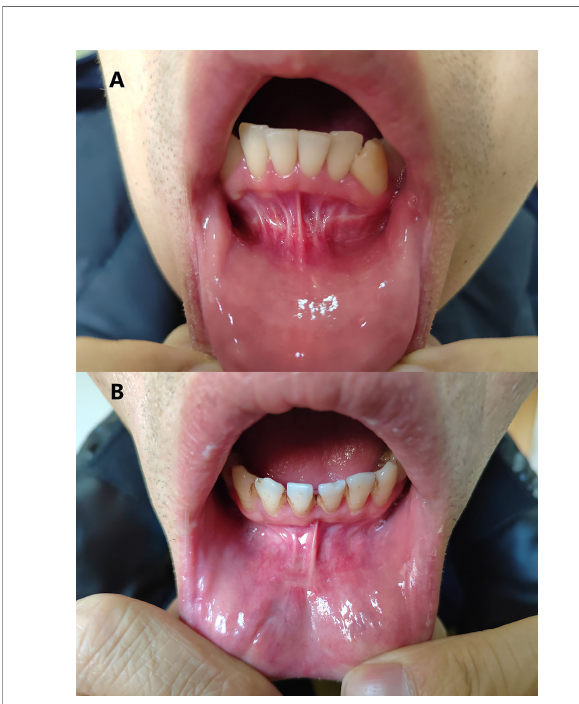
FIGURE 3 | Wrinkle between the submental skin and the skin of the neck. FIGURE 2 | Differences in oral scars after TOETVA for different incision types.